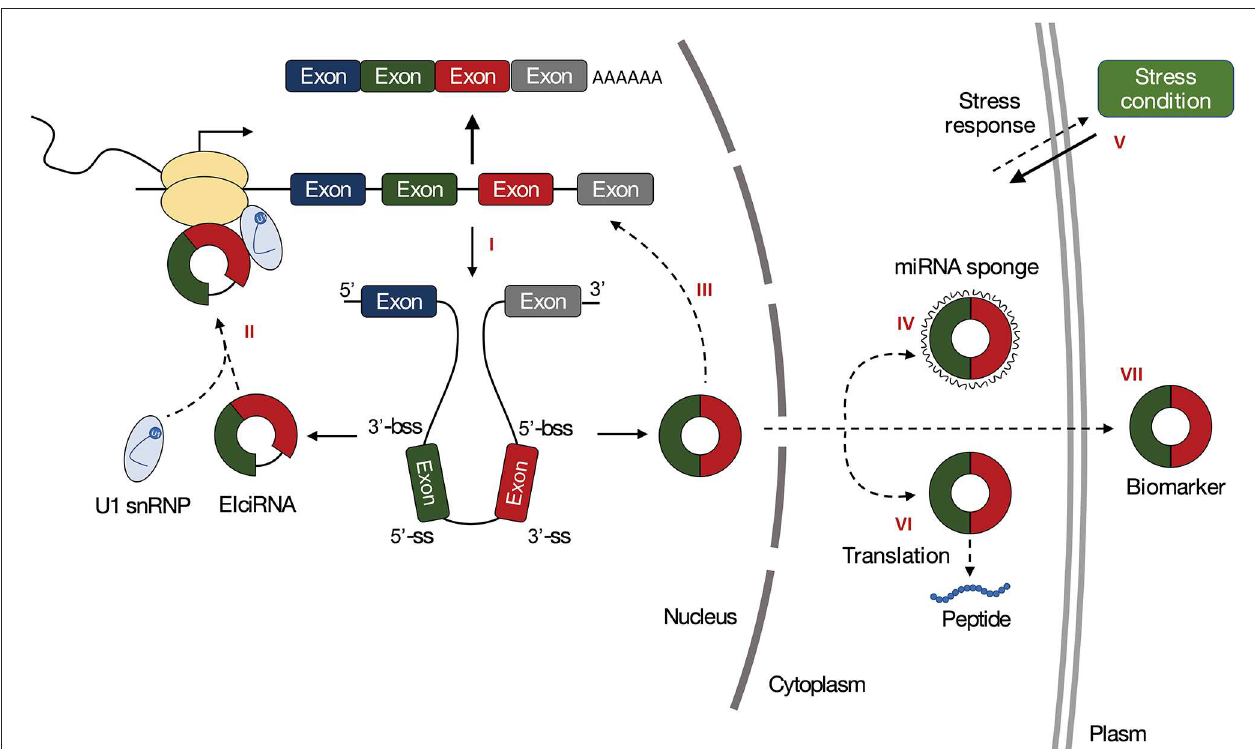
FIGURE 2 | Functions of circRNAs in plants. (I) The processing of circRNAs can affect the splicing of their linear counterparts. (II) CircRNAs can regulate transcription of their parental genes. (III) CircRNAs can regulate the splicing of their linear cognates. (IV) CircRNAs can act as miRNA sponges. (V) CircRNAs can regulate gene expression in response to biotic or abiotic stresses. (VI) CircRNAs can be translated. (VII) CircRNAs are promising